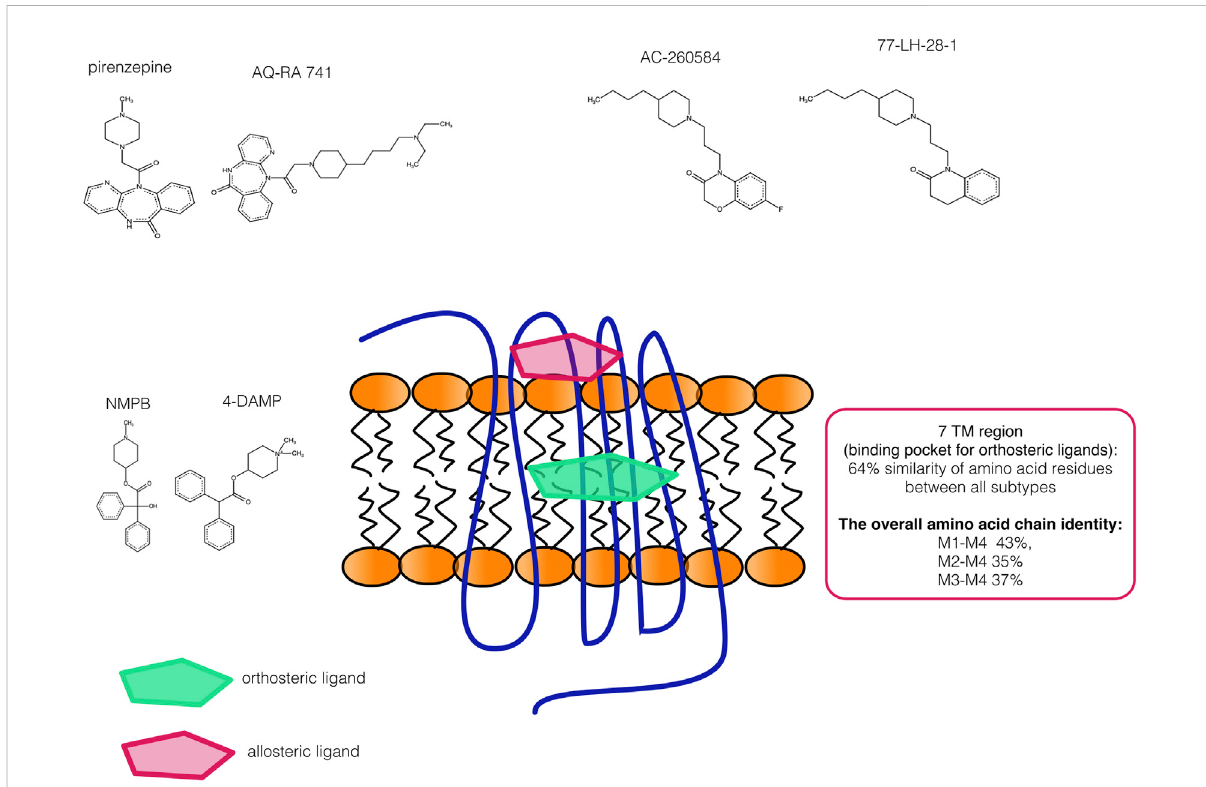
FIGURE 2 The schematic representation of selectivity problem with muscarinic orthosteric ligands. The binding of orthosteric ligands to transmembrane (TM)zonesandbindingsiteofallostericligandsisalsosechamaticallyshown.Thesimilarityinaminoacidchainisshownintheframe.Threeexamples of ligands with similar structure demonstrate that not only amino acid similarity but also ligand structural similarity are the basis of selectivity